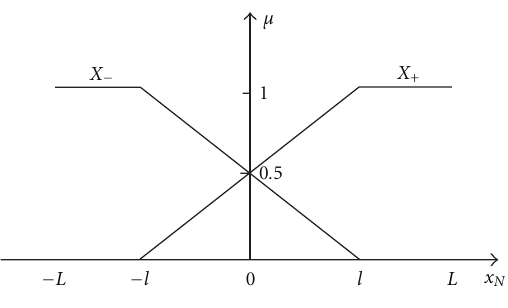
Figure 4: Inferred output membership functions via algebraic product inference.